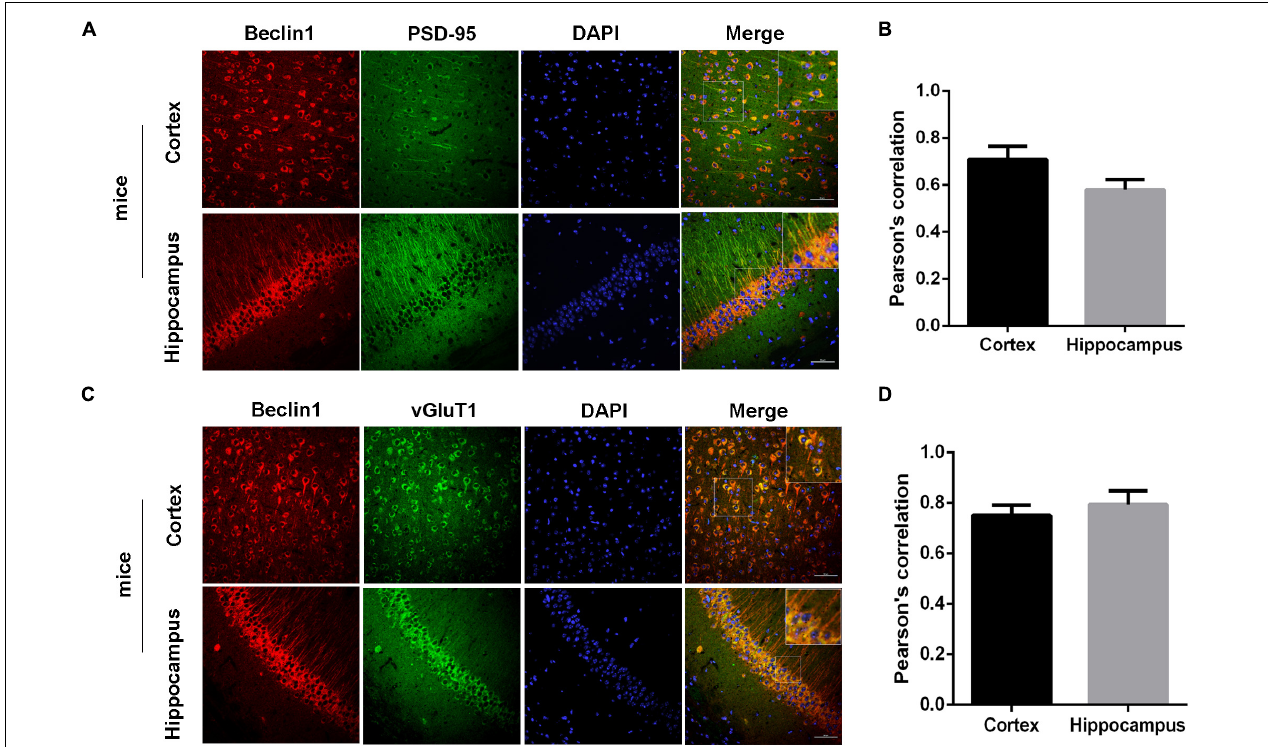
FIGURE 5 | Beclin1 was colocalized with an excitatory synaptic protein. (A) Representative image showing the distributions of Beclin1 and the excitatory postsynaptic protein PSD-95 in mouse brain sections. (B) The extent of the colocalization was quantified using Image-Pro Plus software. (C) Representative image showing the distributions of Beclin1 and the excitatory presynaptic protein vGluT1 in mouse brain sections. (D) The extent of colocalization was quantified [wild-type (WT) group: n = 11, beclin1 ± group: n = 9]. Data are presented as the means ± SEM. Scale bars: 50 µ m. Student’s t -tests were